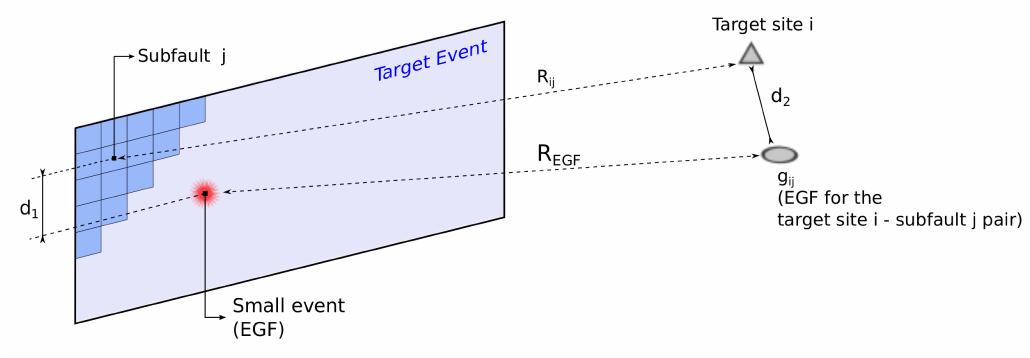
Figure 1. Schematic representation of EGF event selection. Of all the historical records available in the vicinity of target site i from earthquakes on the target fault located in the vicinity of subfault j , the record g ij best represents the path between target site i and subfault j